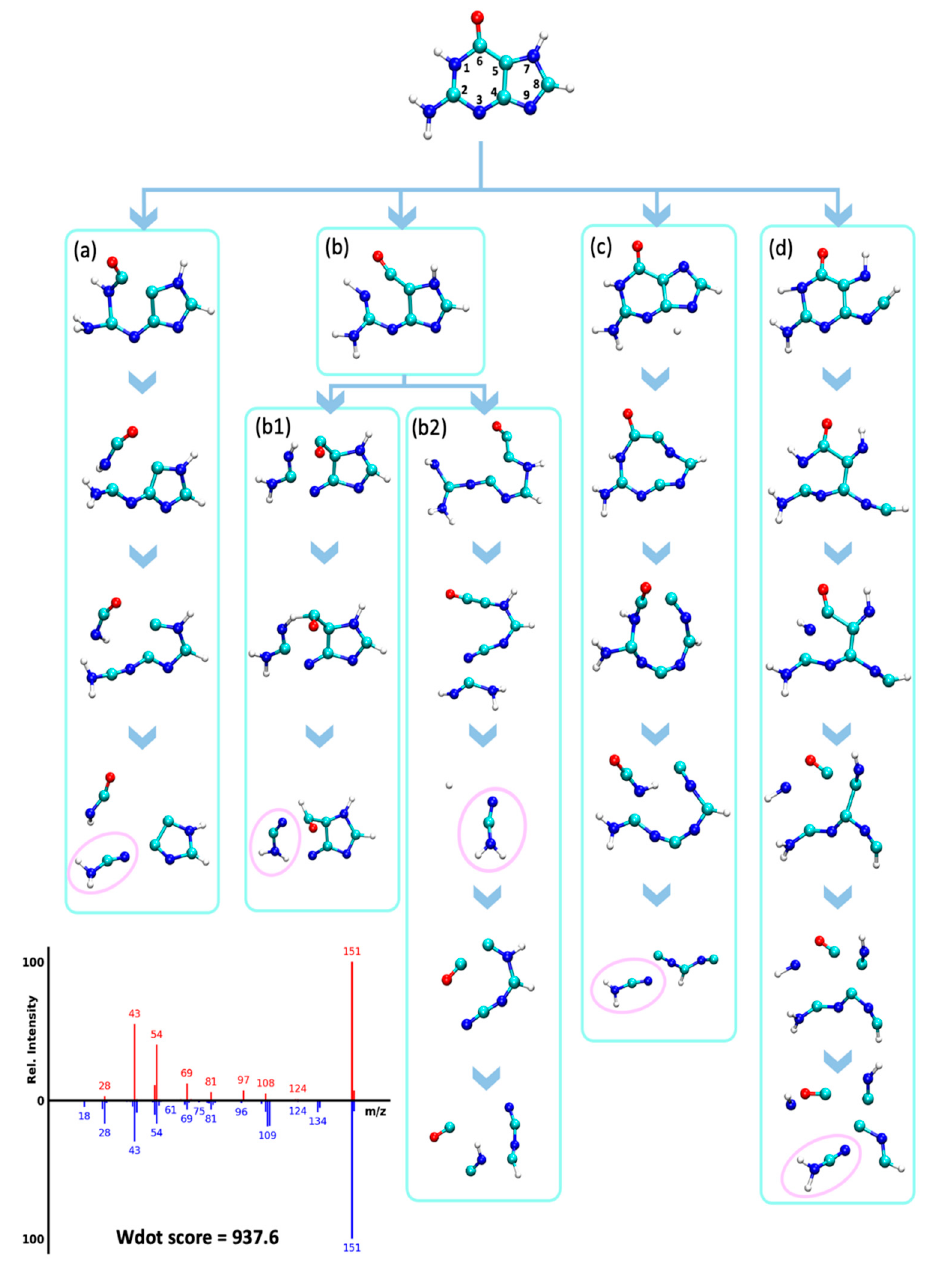
Figure 8. Analysis of QCEIMS trajectories for guanine marking multiple dissociation pathways ( a – d ) to lose cyanamide (CN 2 H 2 , 42 u, noted as pink circles). Note: none of the trajectories predicted the direct neutral loss of 42 u from the molecular ion to yield m/z 109. Mass spectrum insert: Top: QCEIMS, bottom: experimental spectrum.